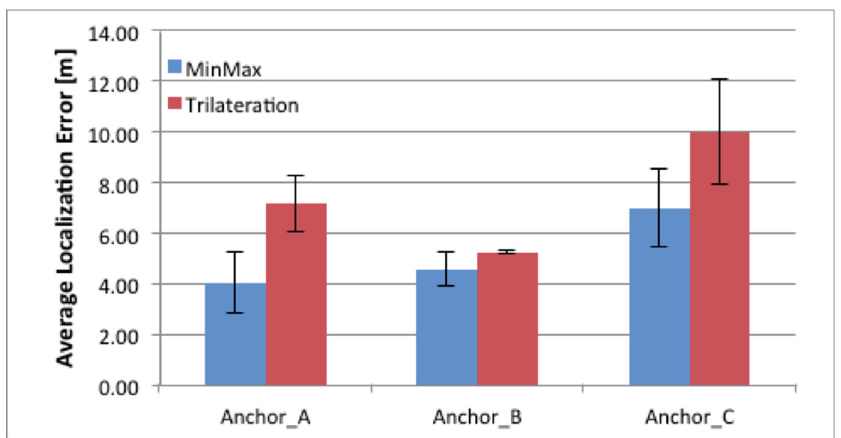
Figure 10. Localization